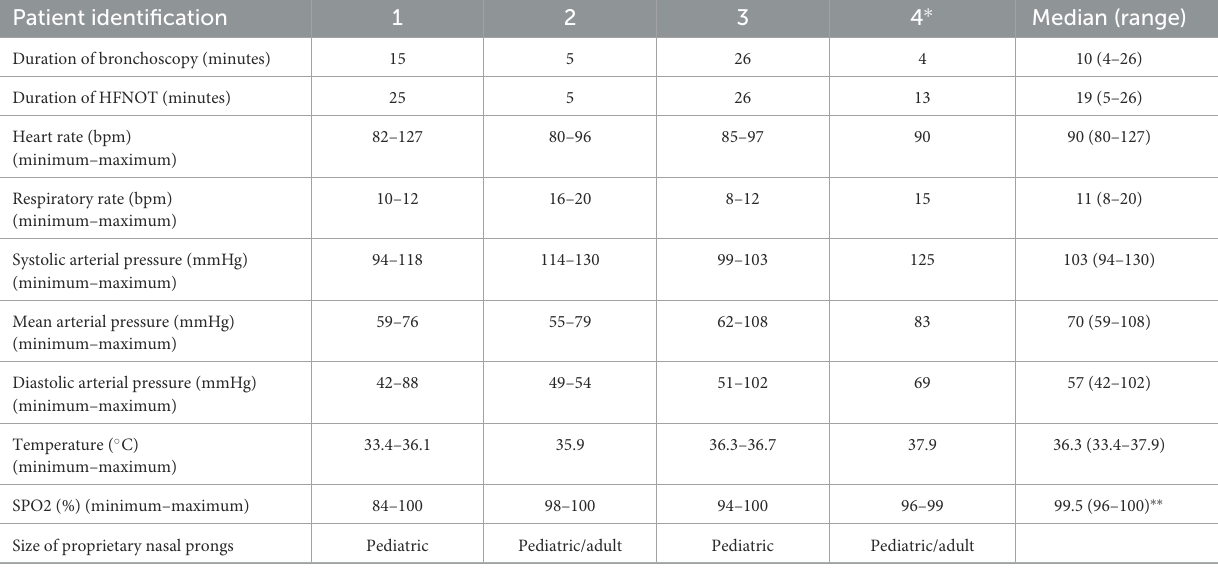
TABLE 2 Monitoring parameters and duration of bronchoscopy and HFNOT.